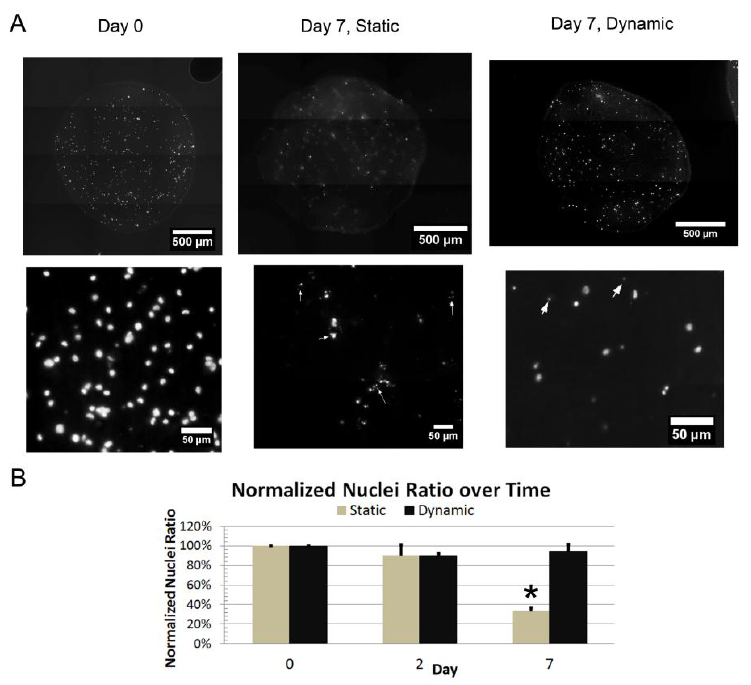
Figure 7. Nuclear Staining of Fibrin Beads with ECFCs: ( A ) Images depicting fibrin bead cross-sections stained for nuclei at day 0 and day 7 for beads cultured statically or dynamically; ( B ) Graph showing the normalized nuclei count up to day 7 (* indicates p <